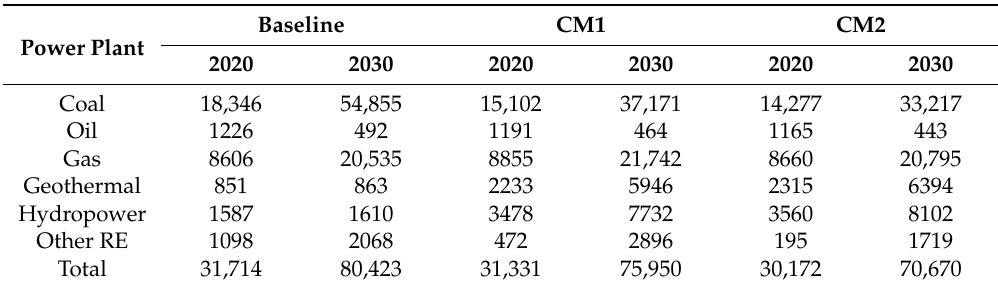
Table 2. Power generation by fuel type for the three scenarios, in Ktoe (1000 toe)/year. CM1 and CM2: countermeasure 1 and 2